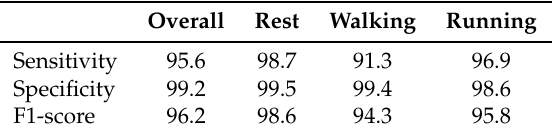
Table 7. Classification results, using the smart annotation model (SA-AXGZ8), on the continuous test data on a per sample basis. All calculated per person and then per class and displayed as a percentage.